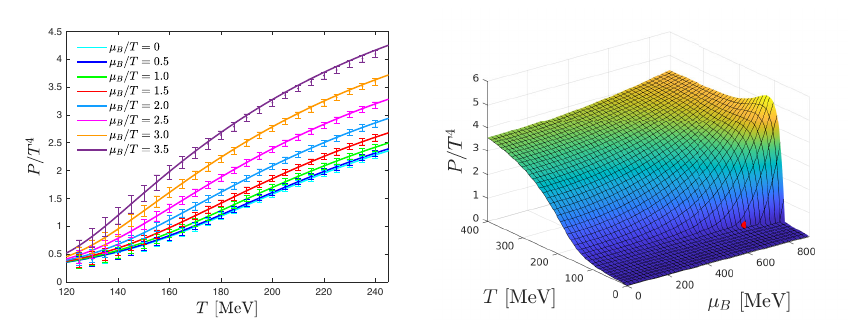
Figure 1. Left: normalized pressure as a function of the temperature for di ff erent values of µ B / T and its comparison with the most recent lattice results. Right, the pressure in the phase diagram with the location of the CEP (red